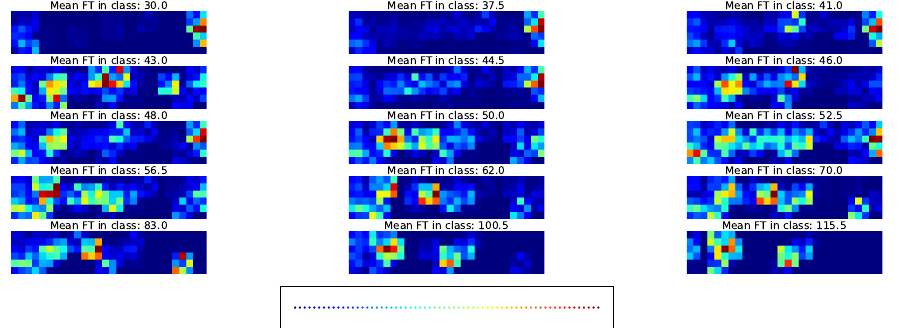
Figure 11. Average saliency maps for time classes and cross-SNP set. Figure S2 gives the same data with higher magnification.